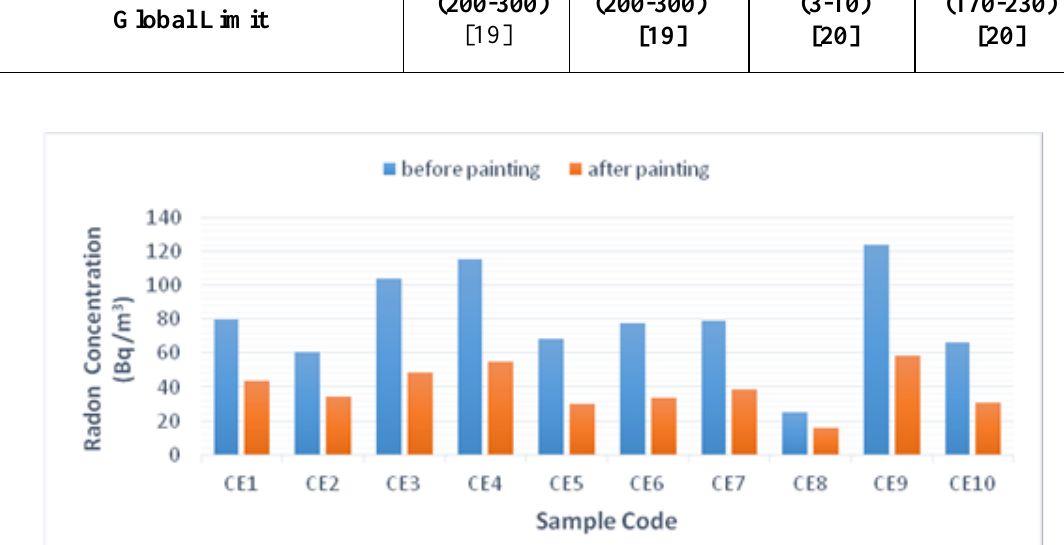
Figure 3: C levels for cement samples before and after Rn